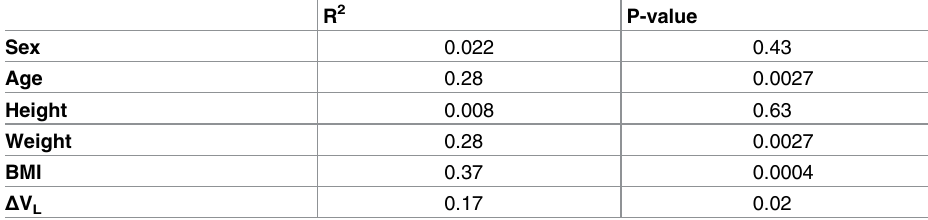
Table 2. Values of R 2 for linear model of Δ R 1 versus general demographics, for n = 30 subjects.